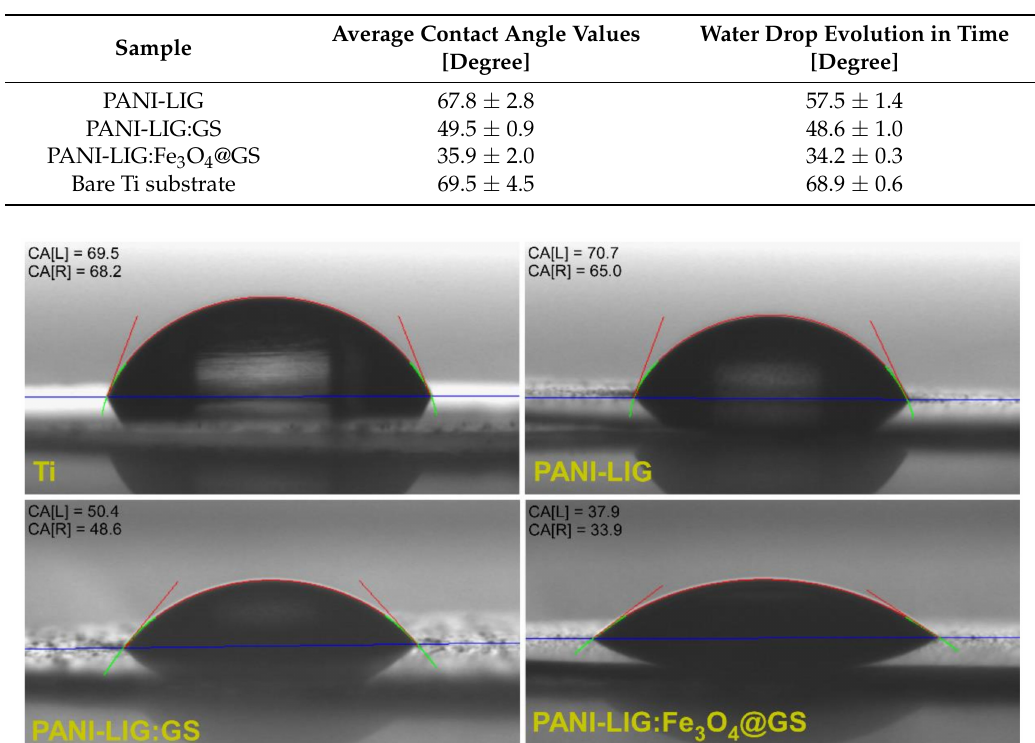
Table 2. The contact angle (CA) values for PANI-LIG based coatings.